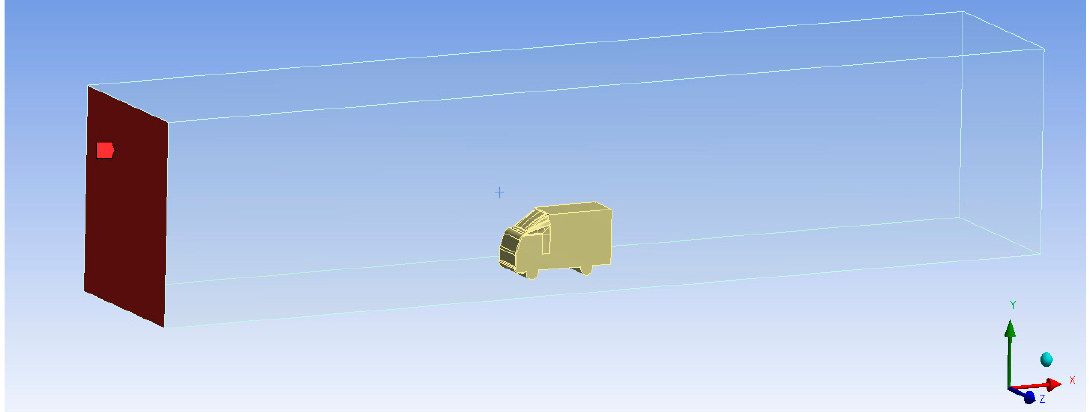
Figure 7. The de fi nition of inlet and outlet for analysis. Figure 7. The definition of inlet and outlet for